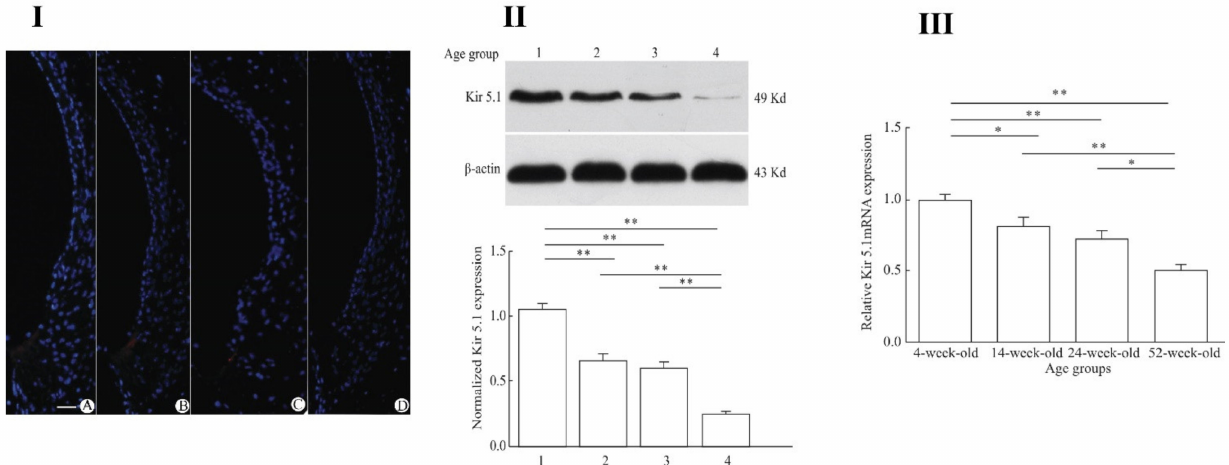
Figure 5. Age-related decrease of Kir 5.1 channels in the cochlear lateral wall of C57BL/6J mice. Cochlea from 4 different age-group C57BL/6J mice were analyzed using three different techniques; immunohistochemistry ( I ) scale bar = 10 µ m, western blotting, ( II ), and RT-PCR ( III ). Four age groups tested: 4-week-old group, 14-week-old group, 24-week-old group, and 52-week-old group. There was a steady decrease in Kir 5.1 expressions levels at both protein and gene levels with age. * p < 0.05, ** p < 0.01. From Pan et al. (2016) [193], with permission from the